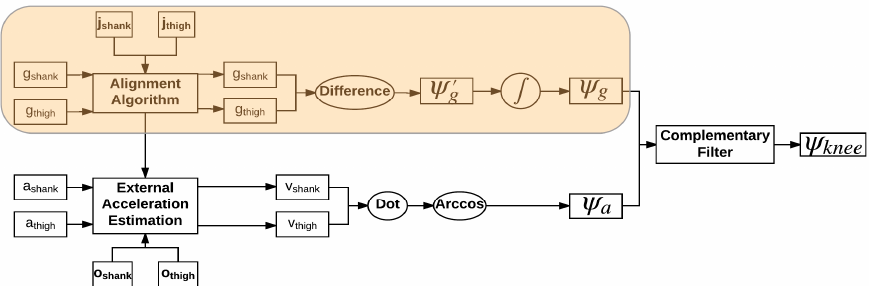
Figure 2. Flowchart of the complimentary filter method to calculate knee joint angle [8]. Alignment algorithm rotates the measured angular velocities g to be aligned with the joint axis j (orientation vector of the joint axis in the sensor reference frame). a , acceleration measured by the accelerometer; o , displacement vector of the joint axis in the sensor reference frame; v , acceleration due to gravity; Ψ ’ , knee angular velocity; Ψ , knee angle.